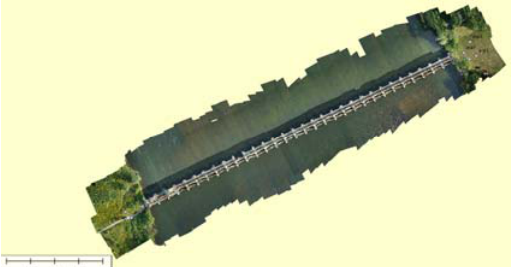
Figure 14: GCPs overlaid on orthophotos displayed in Global Mapper